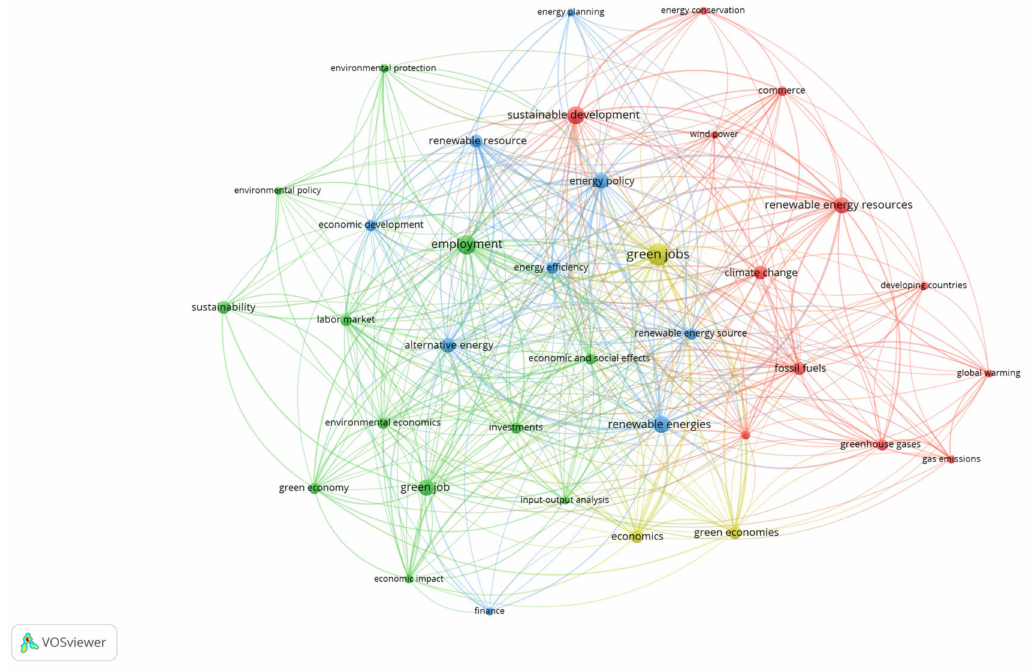
Figure 3. Indexed keyword co-occurrences in the full counting method of Q1 results. Source: Authors’ elaboration in VOSviewer software (1.6.18